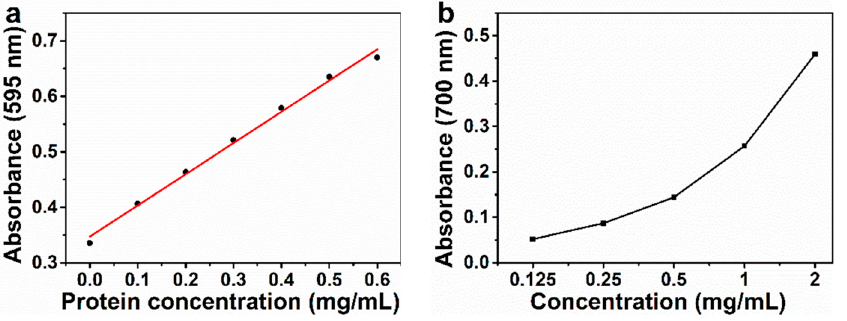
Figure 2. ( a ) The protein content standard curve at 595 nm and ( b ) the reducing ability curve of at 700 GLP at 700 nm.